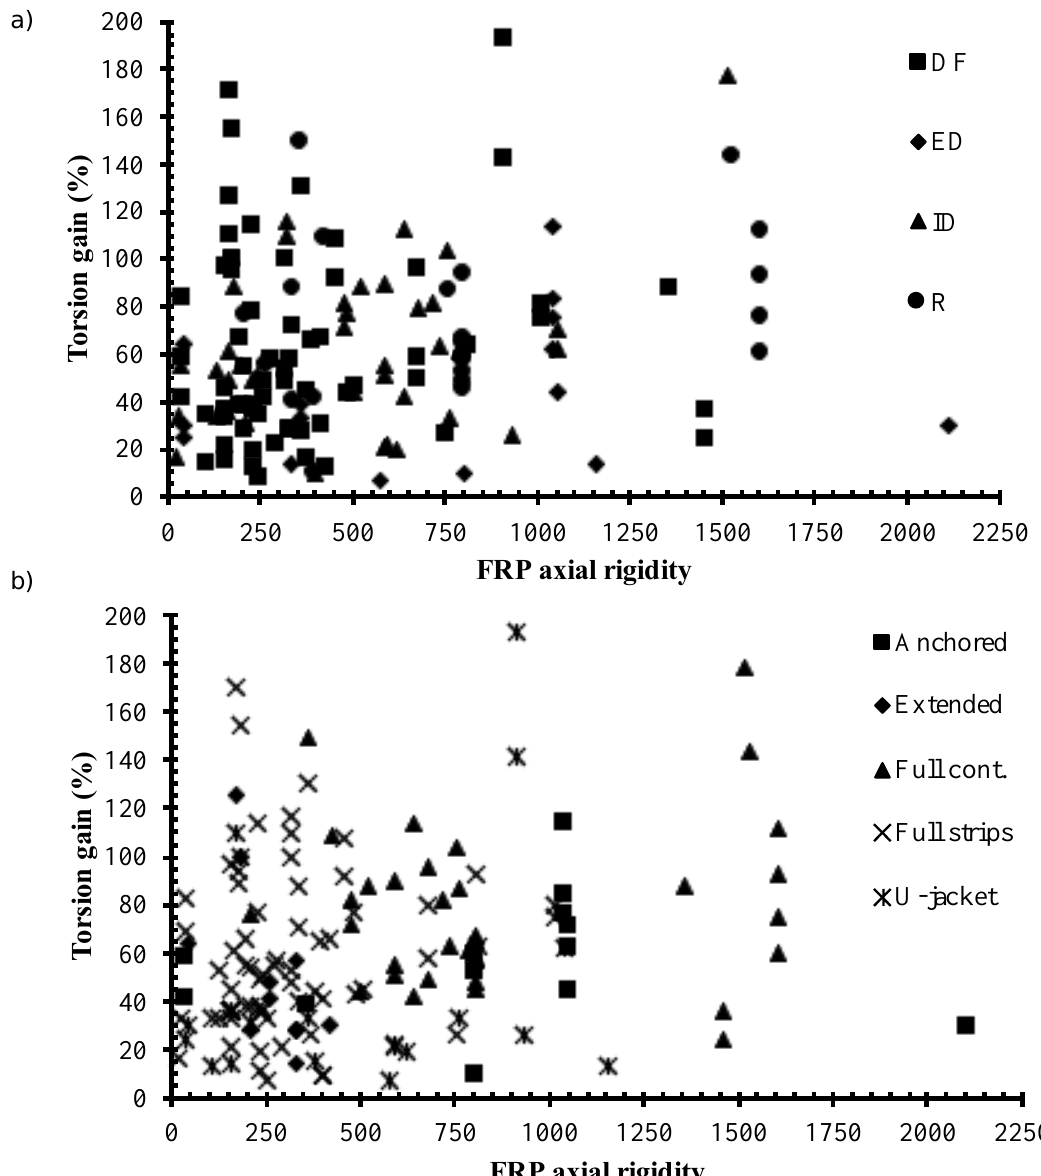
Figure 2. Torsion gain versus FRP axial rigidity ( a ) failure modes and ( b ) strengthening schemes.